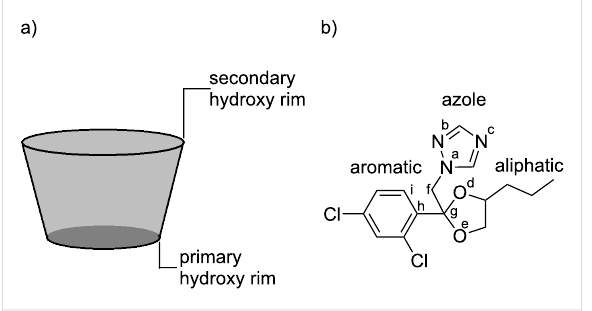
Figure 1: Schematic representation of the β -cyclodextrin (a) and propiconazole (b)